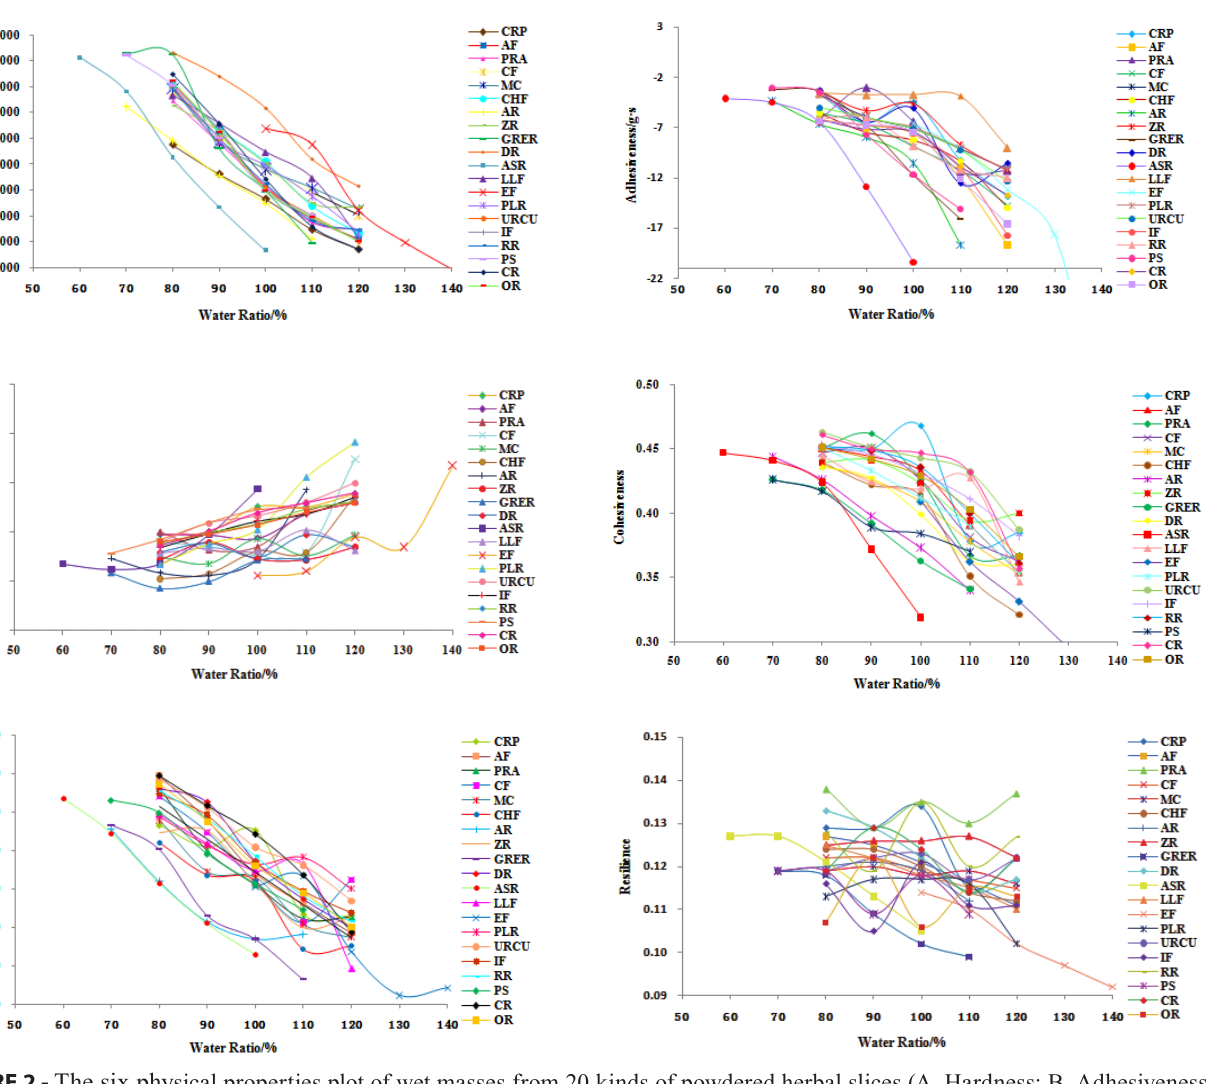
FIGURE 2 - The six phy sical properties plot of wet masses from 20 kinds of powdered herbal slices (A. Hardness; B. Adhesiveness; C. Springiness; D. Cohesiveness; E. Chewiness; F. Resilience).